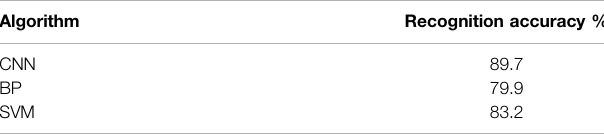
FIGURE 11 | Loss value under different activation functions.